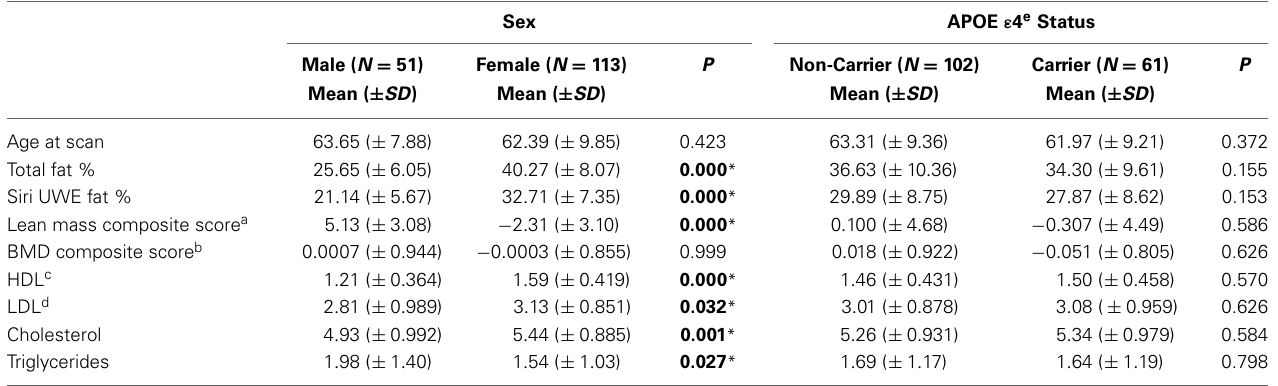
Table 1 | Descriptive findings of dual energy x-ray absorptiometry (DXA) including the p -values corresponding to independent t † .